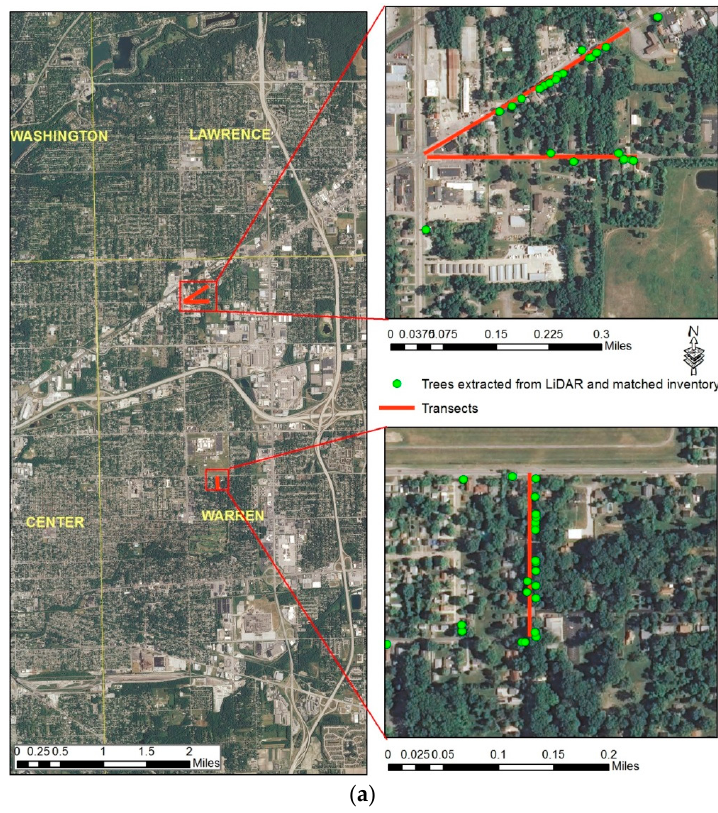
Figure 5. Cont. Figure 5.